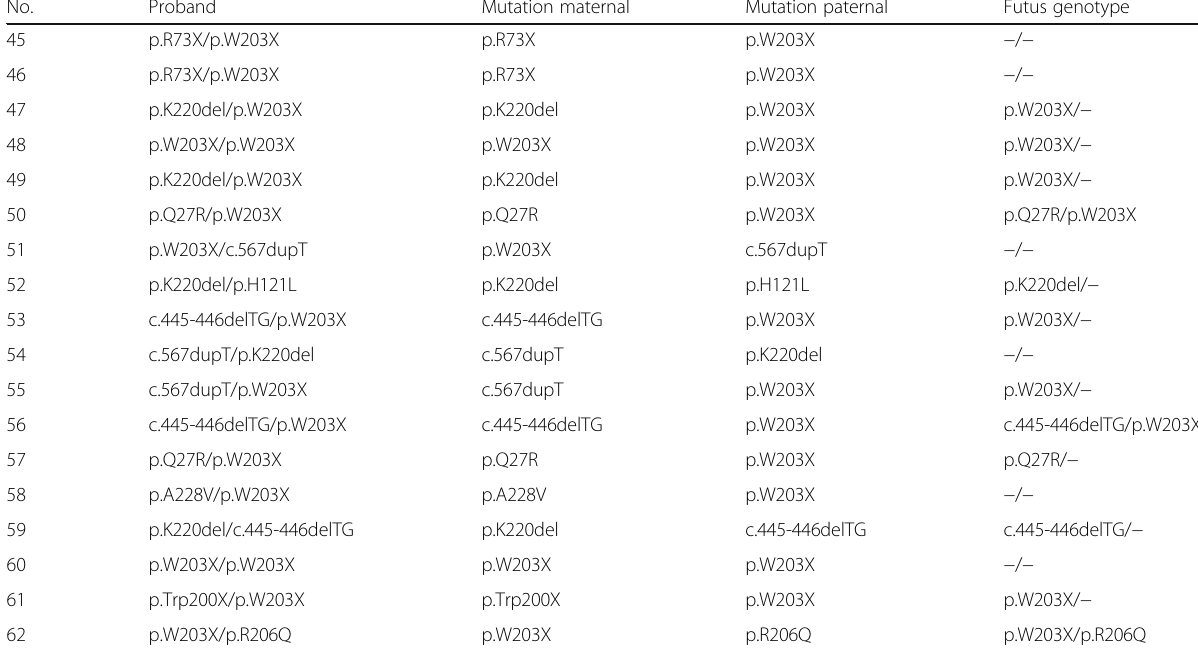
Table 2 The genotypes of 62 pedigrees who have performed the prenatal genetic diagnosis (Continued)